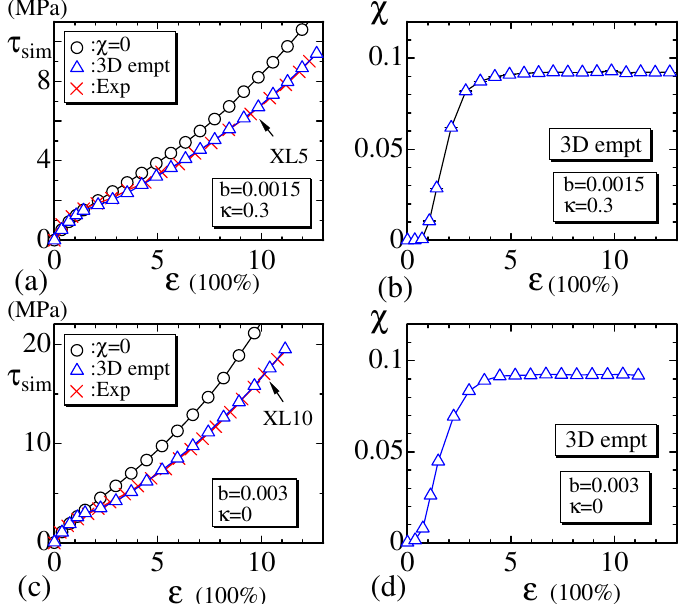
Figure 11. ( a ) The stress τ sim vs. strain ε obtained by the 3D empty model for the experimental data XL5 ( × ) and ( b ) the corresponding χ vs. ε ; ( c ) τ sim vs. ε obtained by the 3D empty model for the experimental data XL10 ( × ) and ( d ) the corresponding χ vs. ε . In both (a) and (c), the symbol ( (cid:13) ) denotes the data without crystallization obtained by assuming the same values of parameters b and κ .